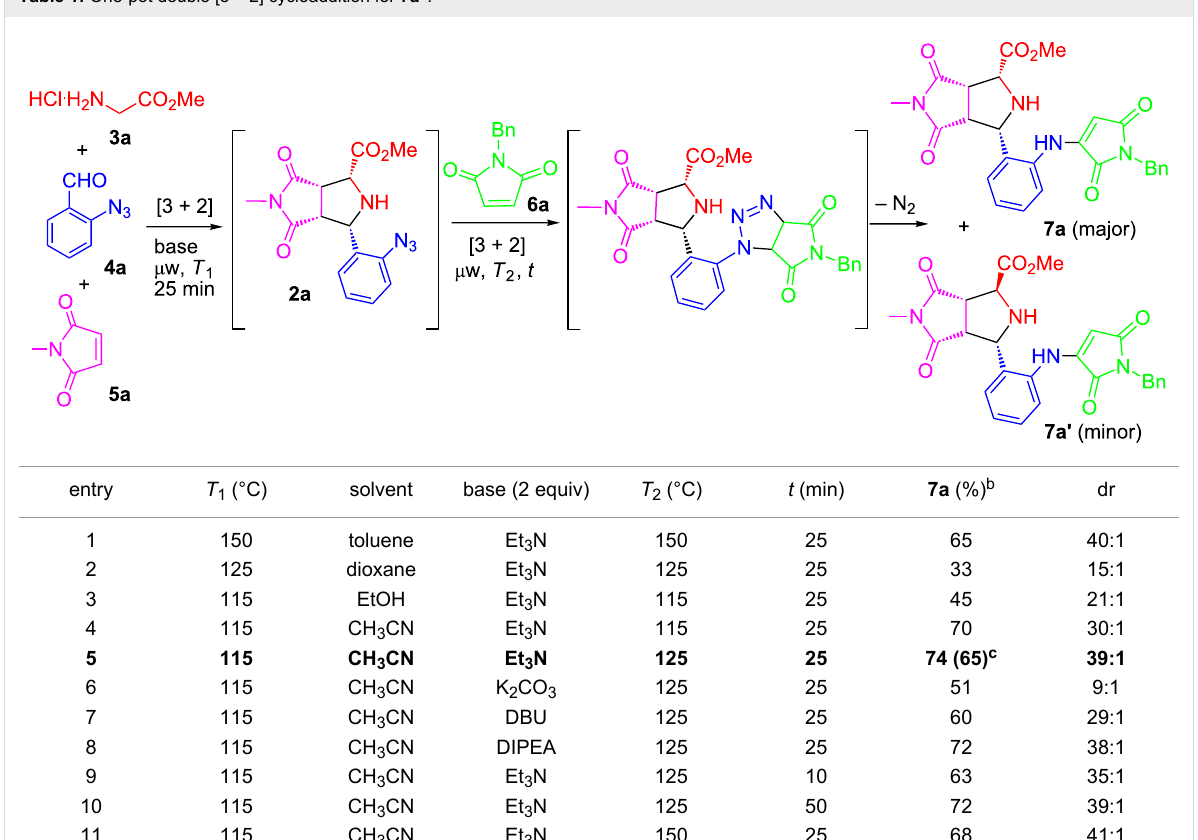
Table 1: One-pot double [3 + 2] cycloaddition for 7a a